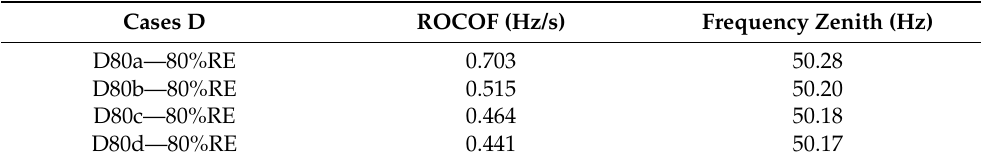
Figure 14. BESS output power under different droop coefficients when no PFC response is obtained from SGs. Table 10. ROCOF and frequency zenith for Group D.